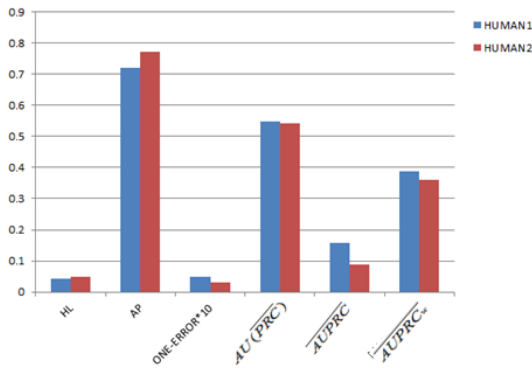
Figure 4. The comparisons between the Human1 and Human2 datasets. Define terms if necessary